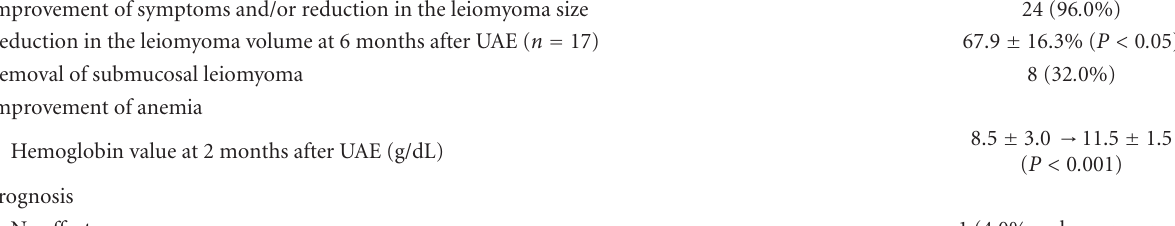
Table 3: Clinical outcomes of UAE in patients with uterine leiomyomas ( n = 25). Improvement of symptoms and/or reduction in the leiomyoma